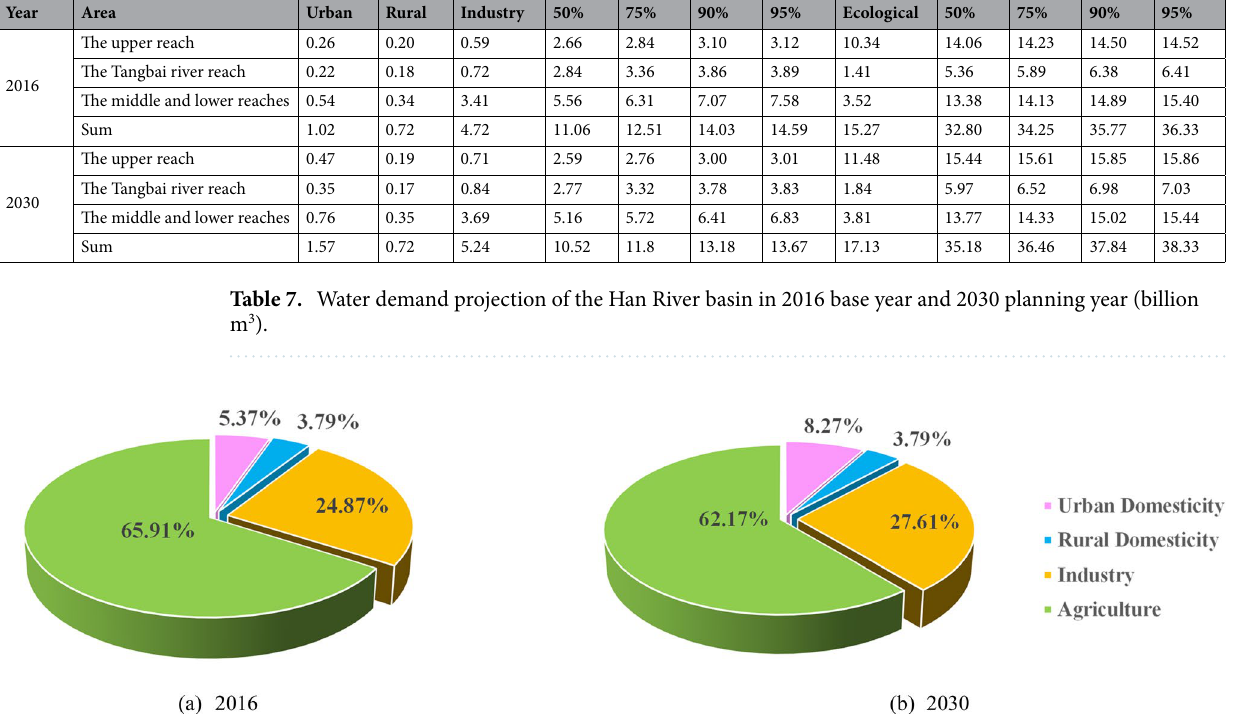
Figure 6. Proportion of different water user sectors to total off-stream water demand